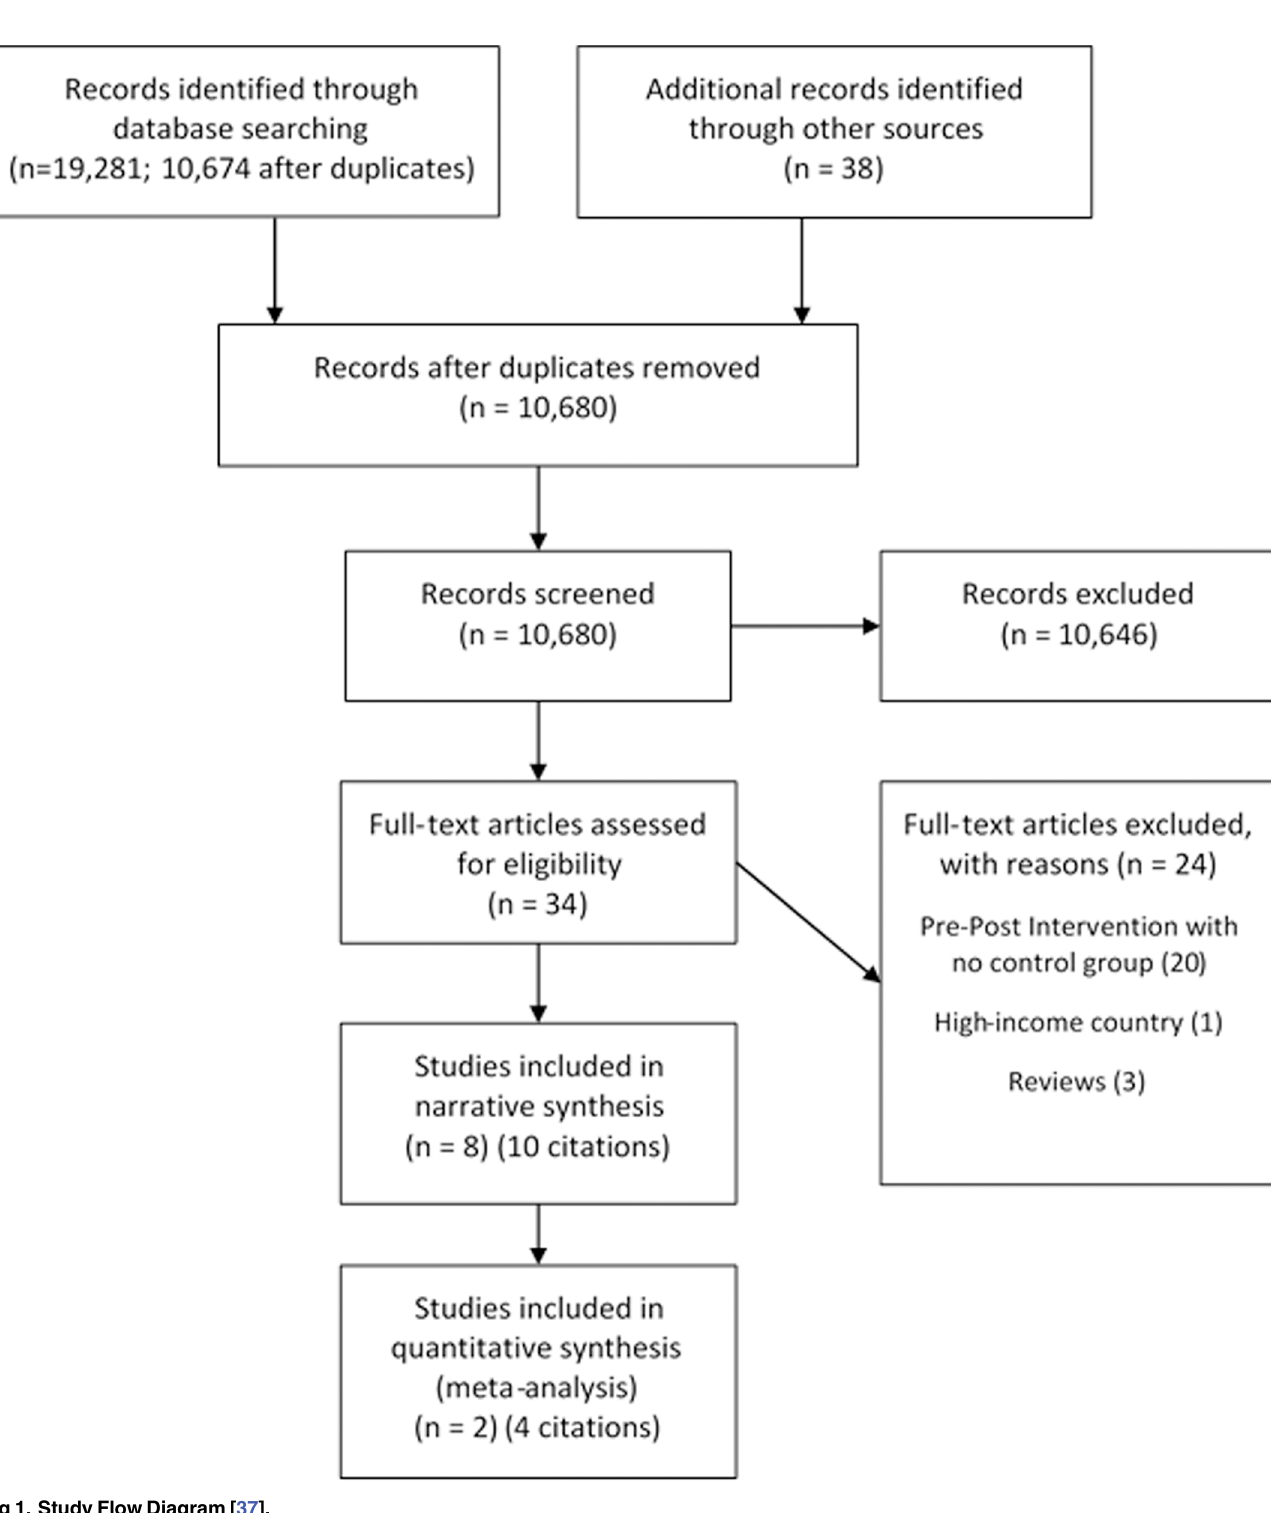
Fig 1. Study Flow Diagram